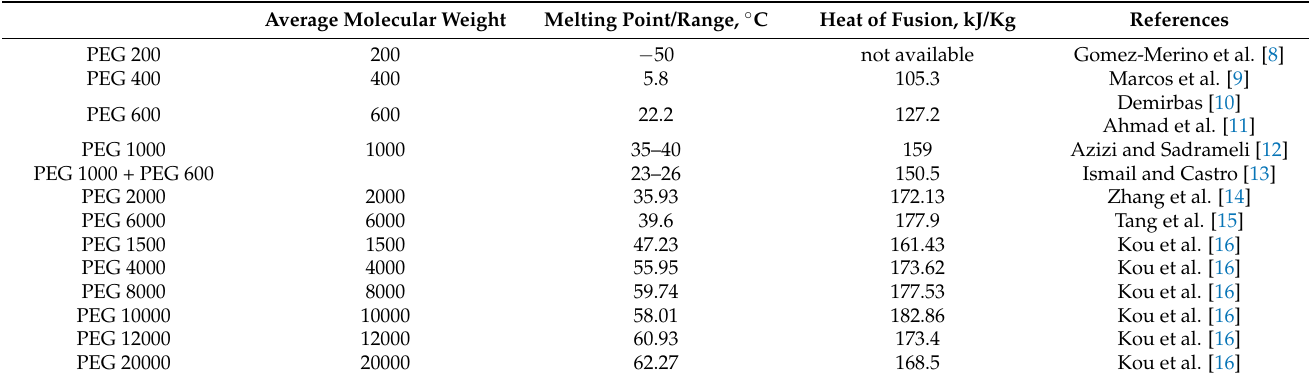
Table 1. Polyethylene glycol (PEG) type PCMs used for cool energy storage applications.